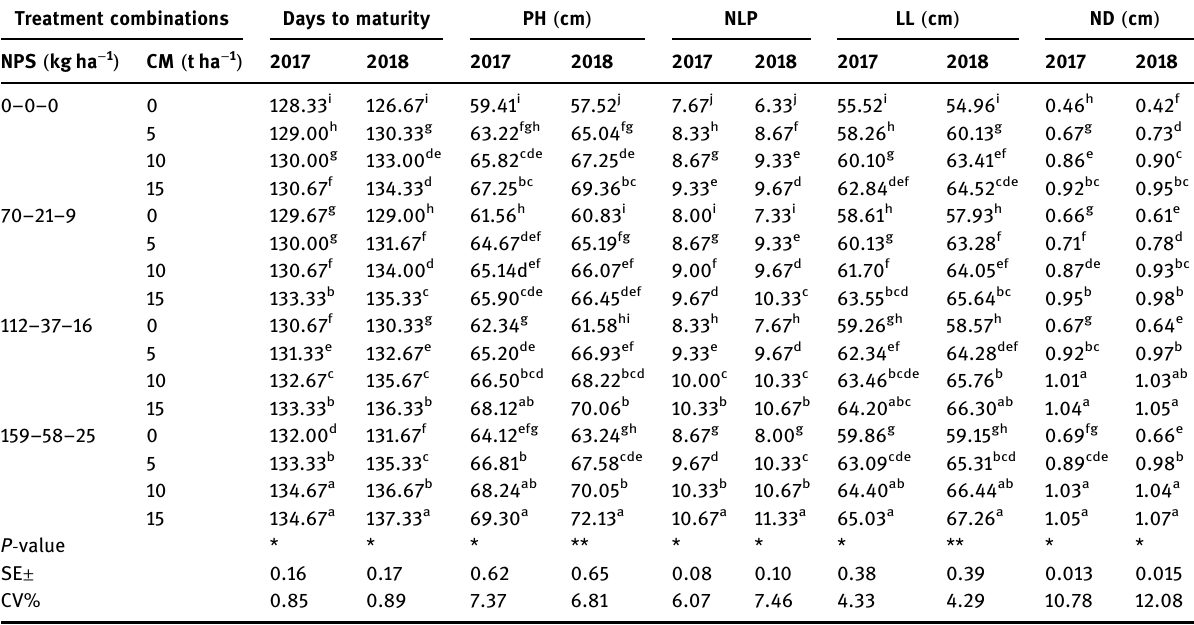
Table 5: E ff ect of NPS inorganic fertilizers and cattle manure application on phenological and vegetative growth parameters of garlic in 2017 and 2018 in northwest Ethiopian highlands Treatment